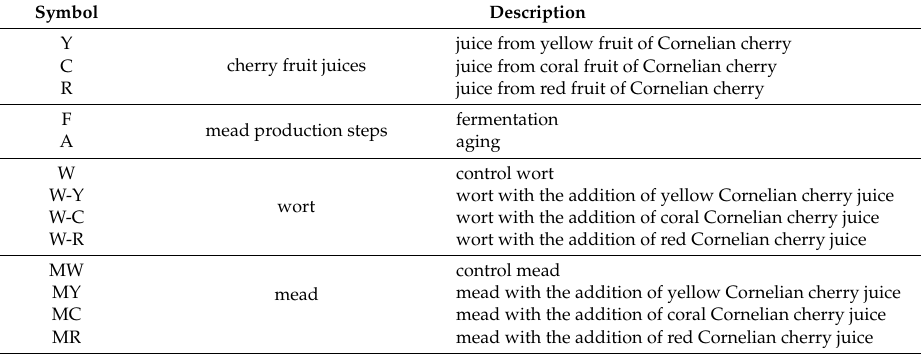
Table 5. Description and symbols of cherry fruit juices used in the experiment, worts, and meads obtained in the